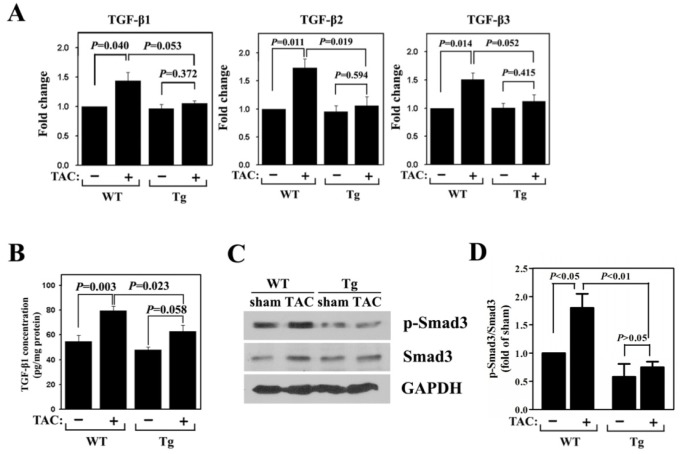
Upregulated TGF-β/Smad signaling is inhibited in CARP Tg mice following TAC.(A) Quantitative detection of TGF-β1, -β2, and -β3 mRNA expression by real-time PCR in hearts from WT and CARP Tg mice subjected to TAC or a sham operation. (B) ELISA measurements of TGF-β1 levels in heart homogenates from WT and CARP Tg mice subjected to TAC or a sham operation. (C) Western blotting to detect phosphorylated and total Smad3 protein in heart protein extracts from WT and CARP Tg mice subjected to TAC or a sham operation. (D) Quantification of the level of phosphorylated Smad 3 shown in (C).